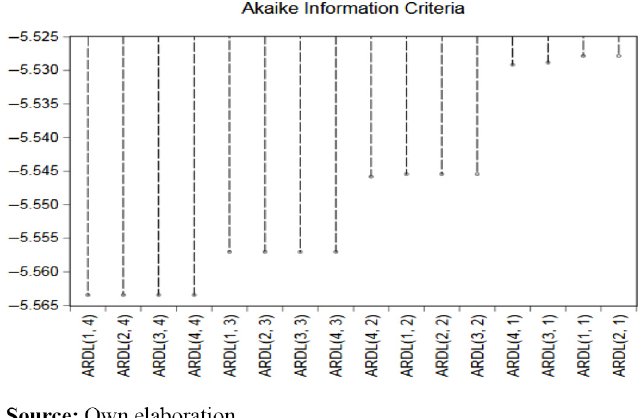
Figure 2. Selection of the optimal ARDL